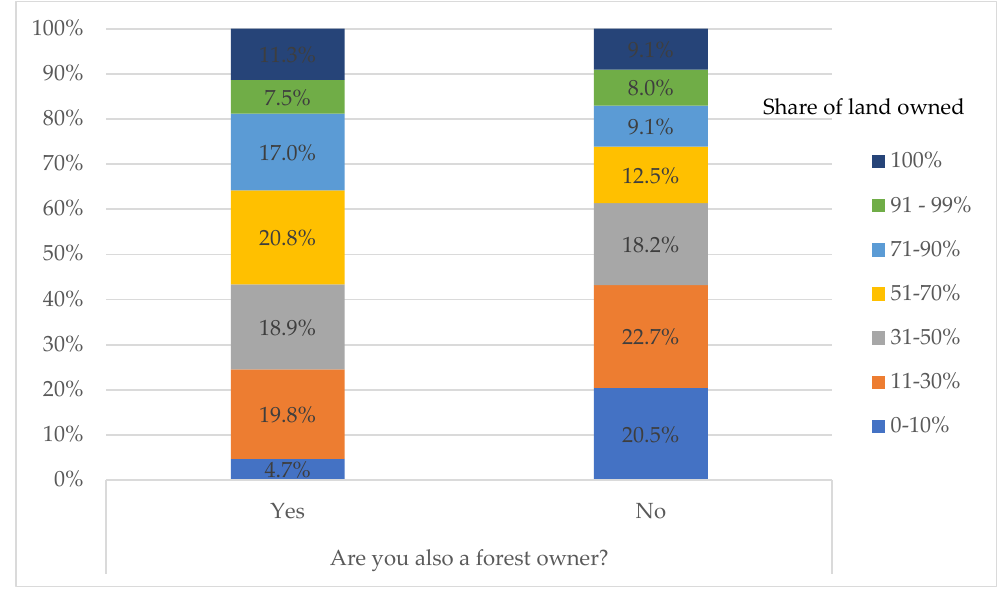
Figure 5. Percentage of land in private ownership by forest ownership.